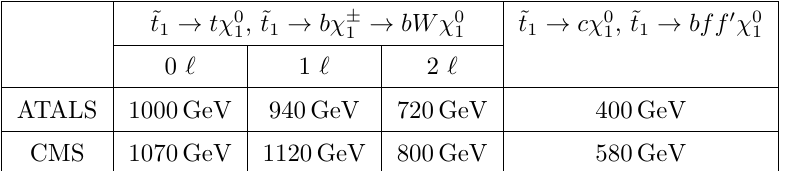
Figure 1 . The branching fractions of three di(cid:11)erent channels t (cid:22) thh function of light stop mass for the mostly left-handed stop pair production. Three choices of M 1 = 3, 150, 300 GeV are presented, with (cid:22) (cid:12)xed to be M 1 + 150 GeV and tan (cid:12) = 10.